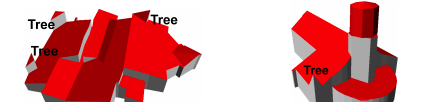
Figure 16: Trees around the left church lead to three small towers at corners of the building. Because of the same reason, the right church has an error at the left front side.